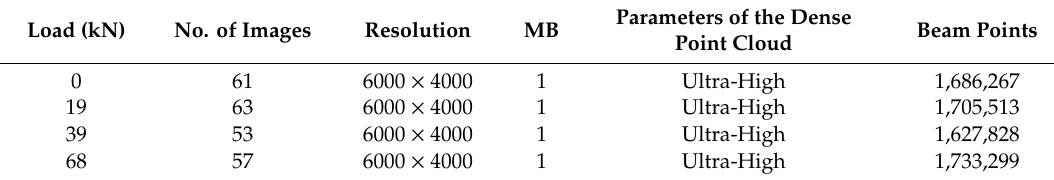
Table 11. Data and processing parameters of the CRP surveys beam#2 EOS M3.